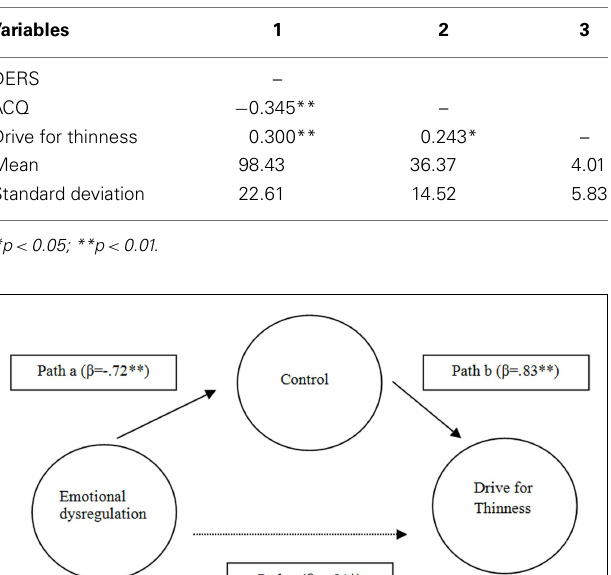
Table 2 | Pearson bivariate correlation, mean, standard deviation .